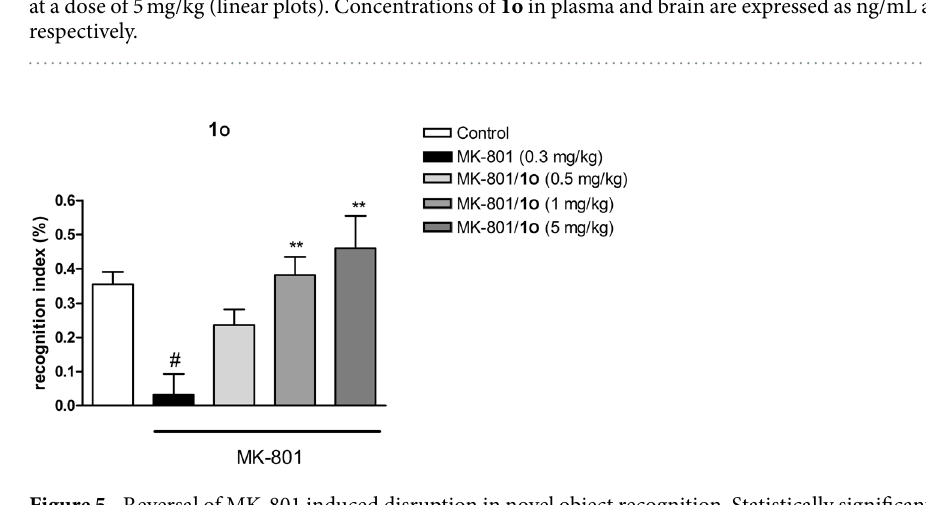
Figure 5. Reversal of MK-801 induced disruption in novel object recognition. Statistically significant effect was found at 1 mg/kg and 5 mg/kg